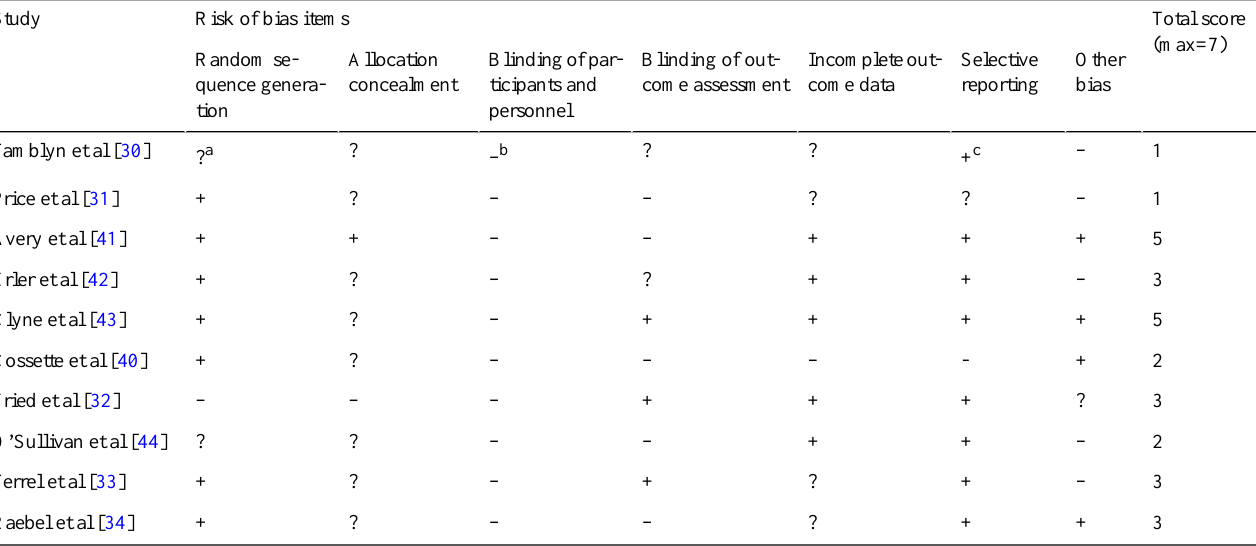
Table 5. Risk of bias assessment (according to Cochrane Collaboration Risk of Bias tool) for the randomized controlled trials (n=10).